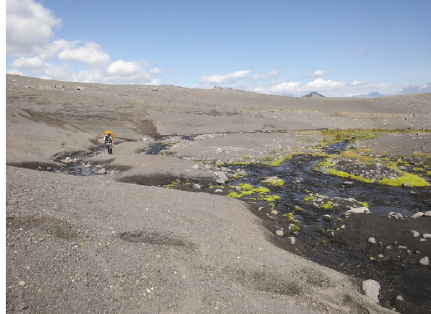
Figure 29: Cold spring (C7) on a Northern slope of Koryaksky Volcano, August 2012. Photo by A. V. Kiryukhin.